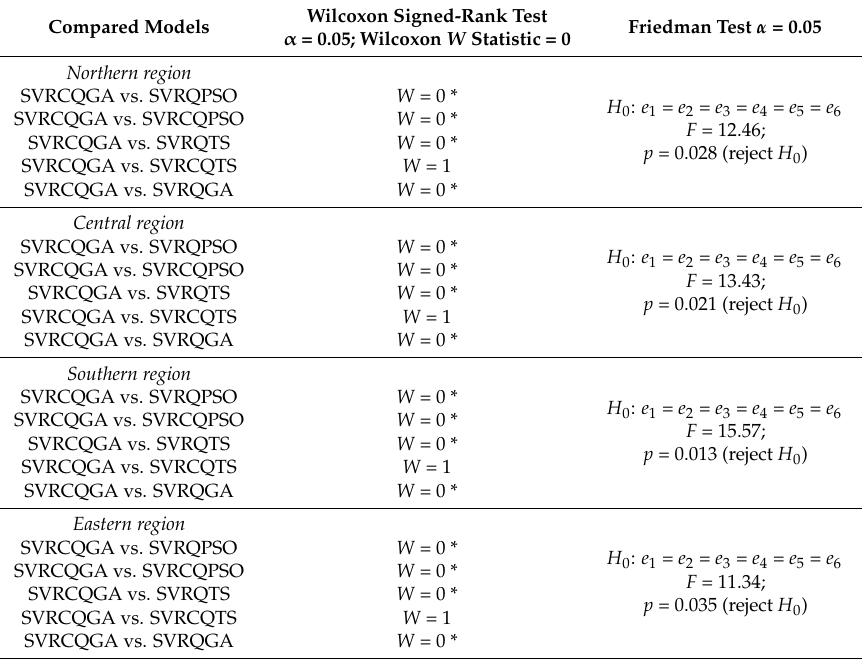
Table 4. Wilcoxon signed-rank test and Friedman test (Example 1).